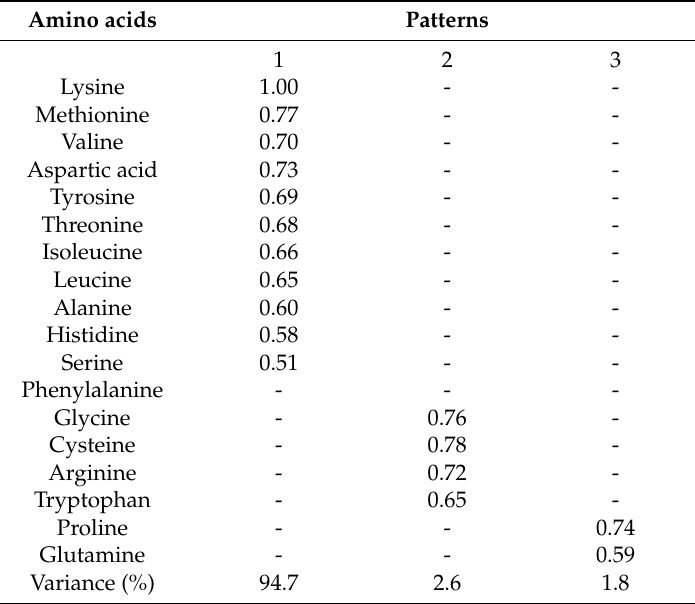
Table 2. Component loadings for dietary amino acid